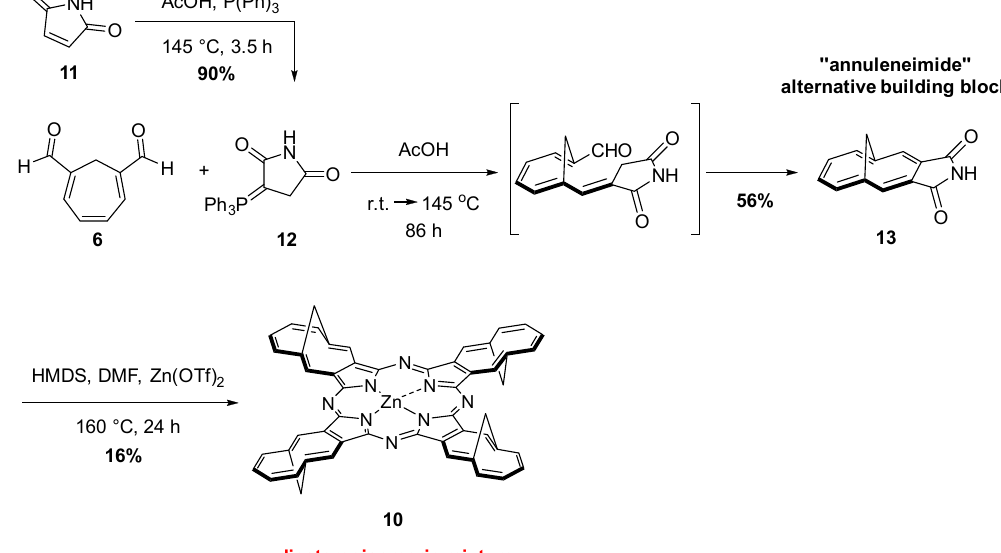
Scheme 5. Alternative approach to the synthesis of 10 .